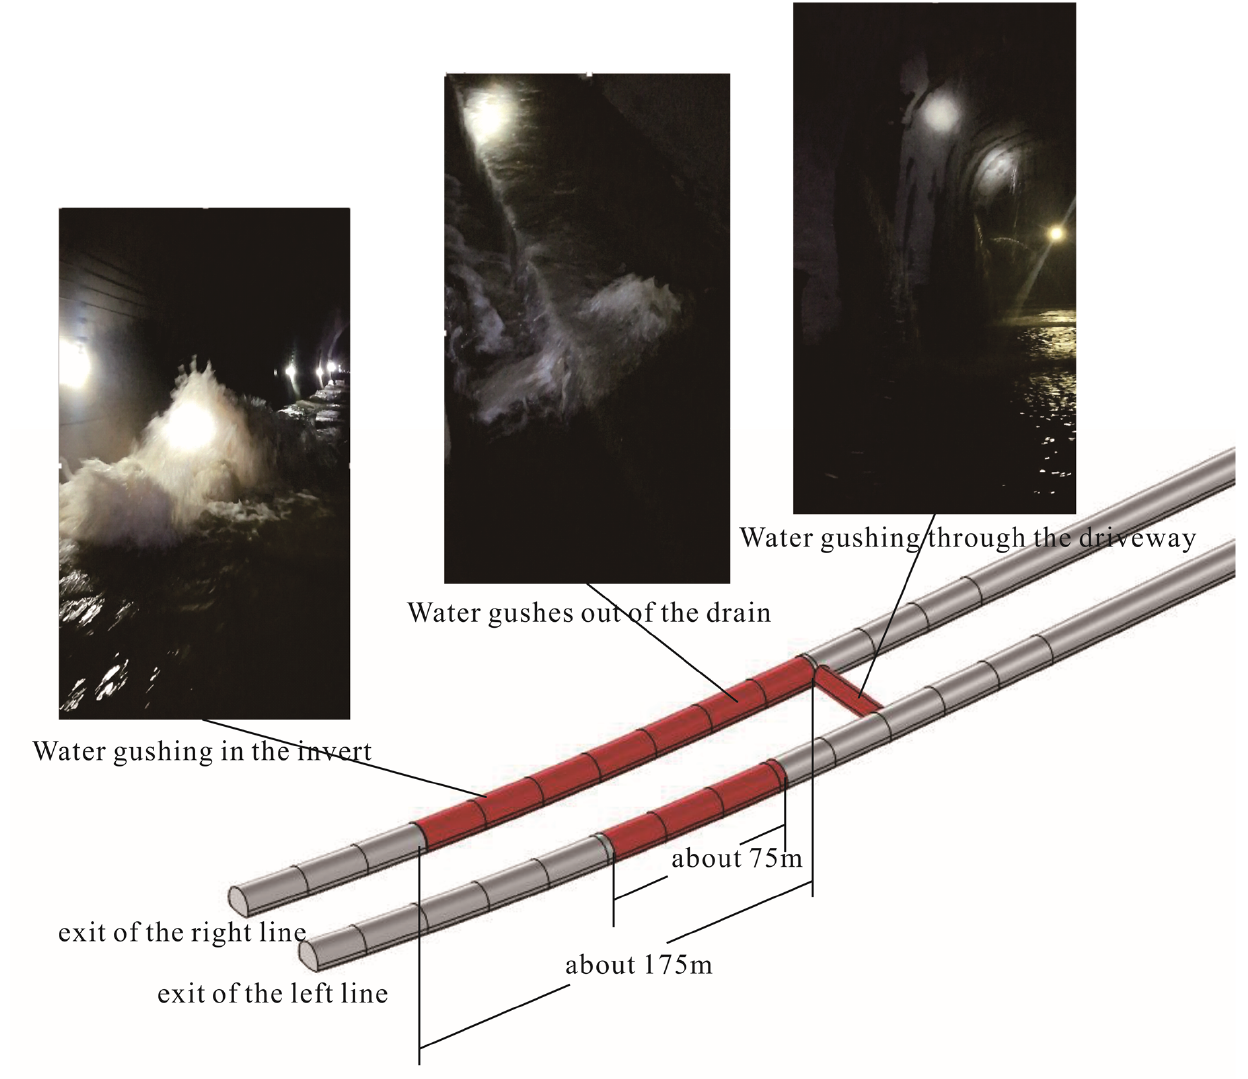
Figure 6. Water inrush in the tunnel.